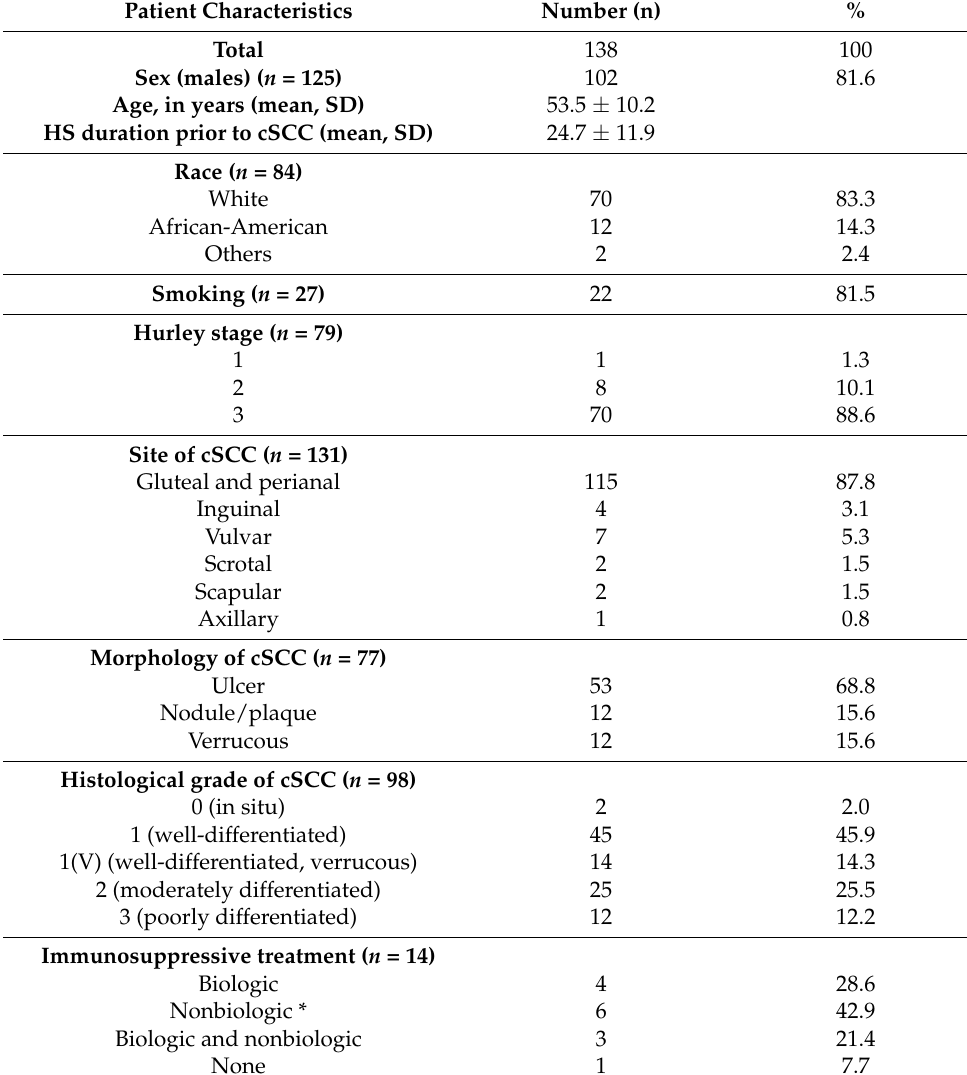
Table 1. Demographic and clinical characteristics of